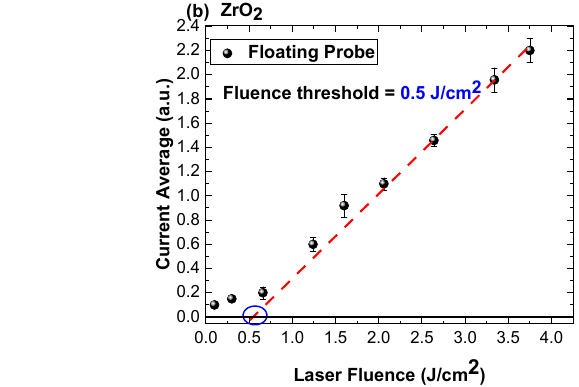
Figure 2. Unbiased LP current temporal traces recorded at 1 cm from the target for different irradiation fluence conditions presented for long ( a ) and short time scales ( b ).